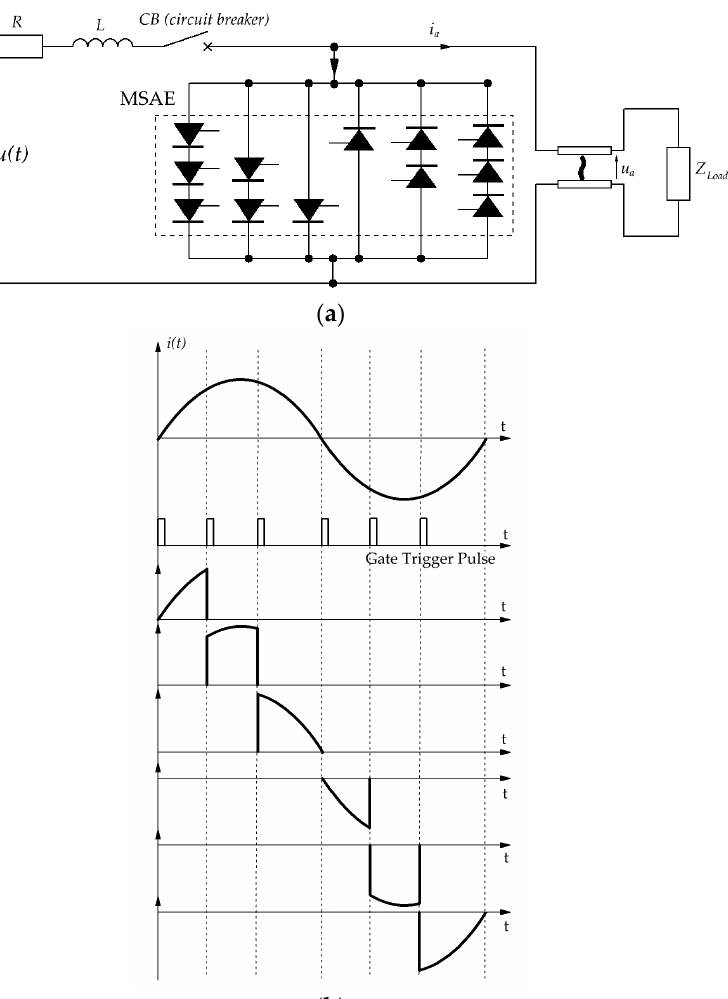
Figure 3. Multi-sectional structure of thyristors and operation of the MSAE: ( a ) Electrical scheme for an AC circuit with arc and MSAE made by the thyristors, ( b ) an example of sequential taking over current by shunting paths in the order in which thyristors are triggered.